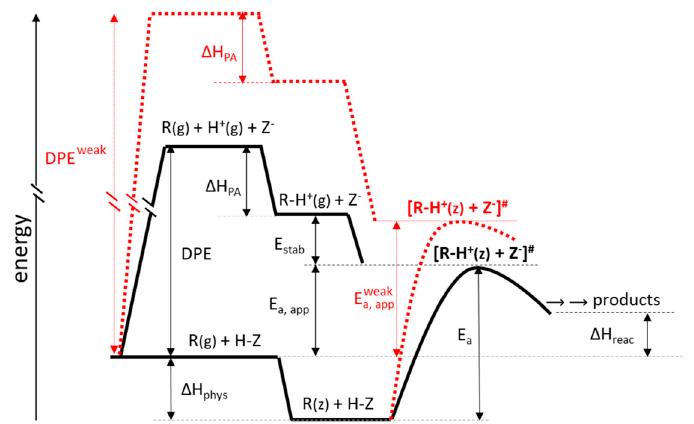
Figure 8. Thermochemical cycle showing the relation between the DPE and the apparent activa- tion energy for alkane cracking over H-Z. Note that the cycle is not to scale as the DPE is much larger than the activation energy. An order of magnitude estimation of the different enthalpies/energies are (kJ/mol): ∆ H phys ~45, E a ~200, DPE~1200, ∆ H PA ~700.